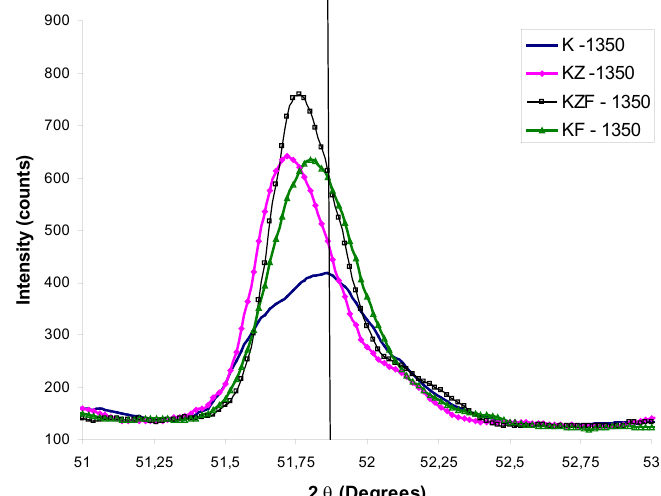
Figure 5. C S peaks in the XRD window 2 ϴ 3